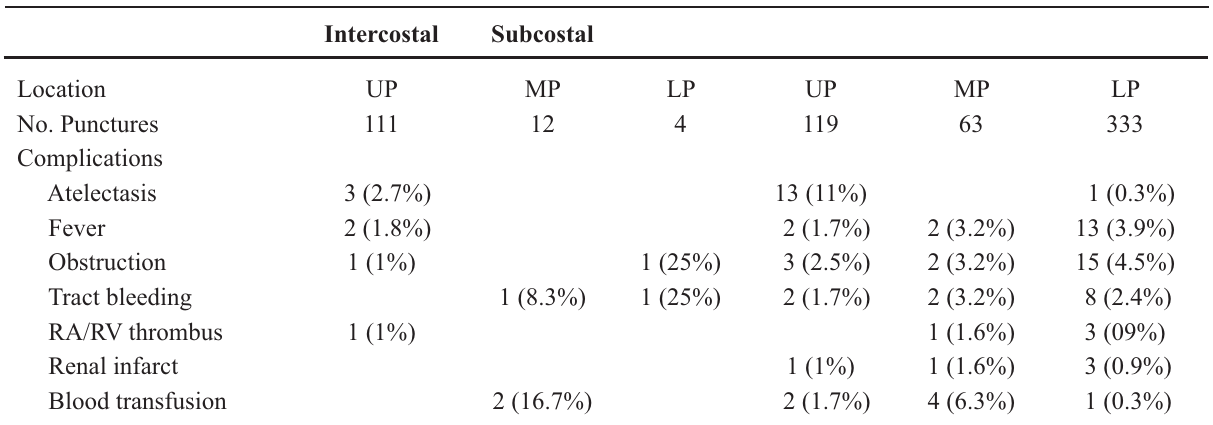
Table 4 – Minor complications at various access